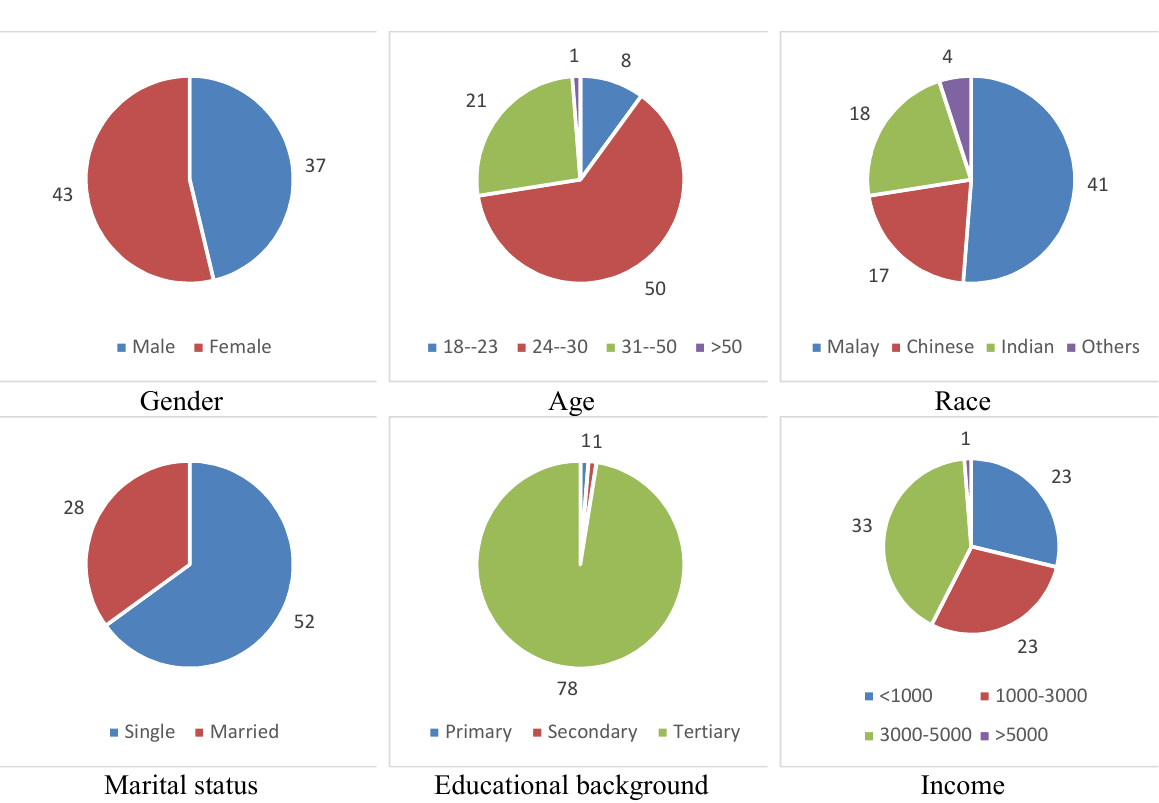
Fig. 1. Personal characteristics of the participants